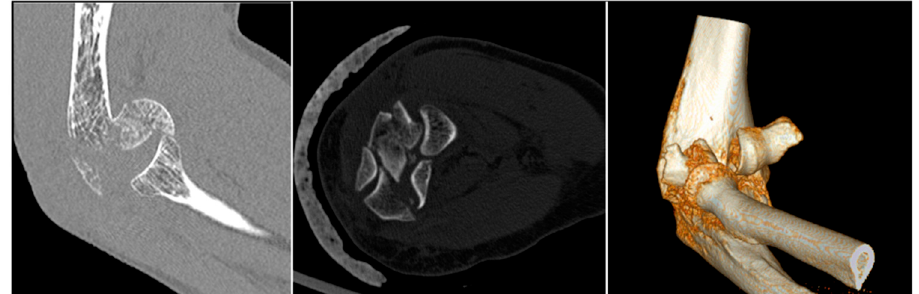
Figure 6. CT scan with 3D reconstruction helps the surgeon detect posterior comminution, analyze the number of fracture fragments, and understand the medial extension of the fracture.